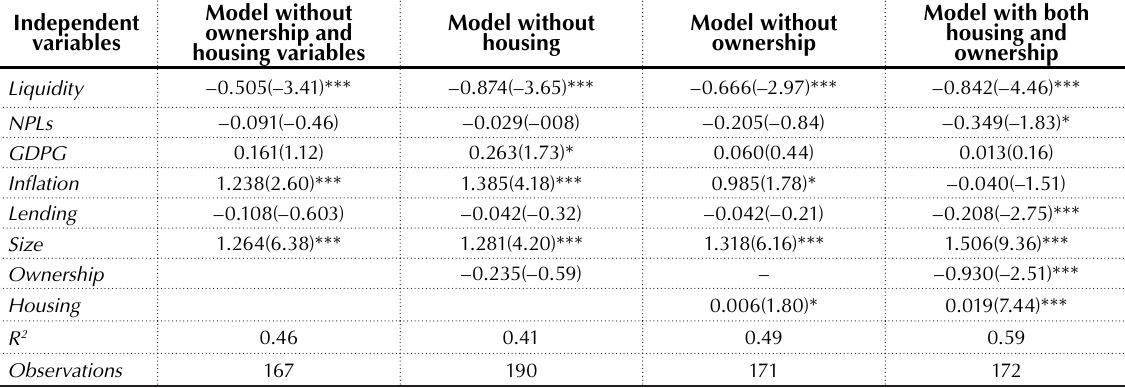
Table 2. The dependent variable is foreign loans of commercial banks Independent